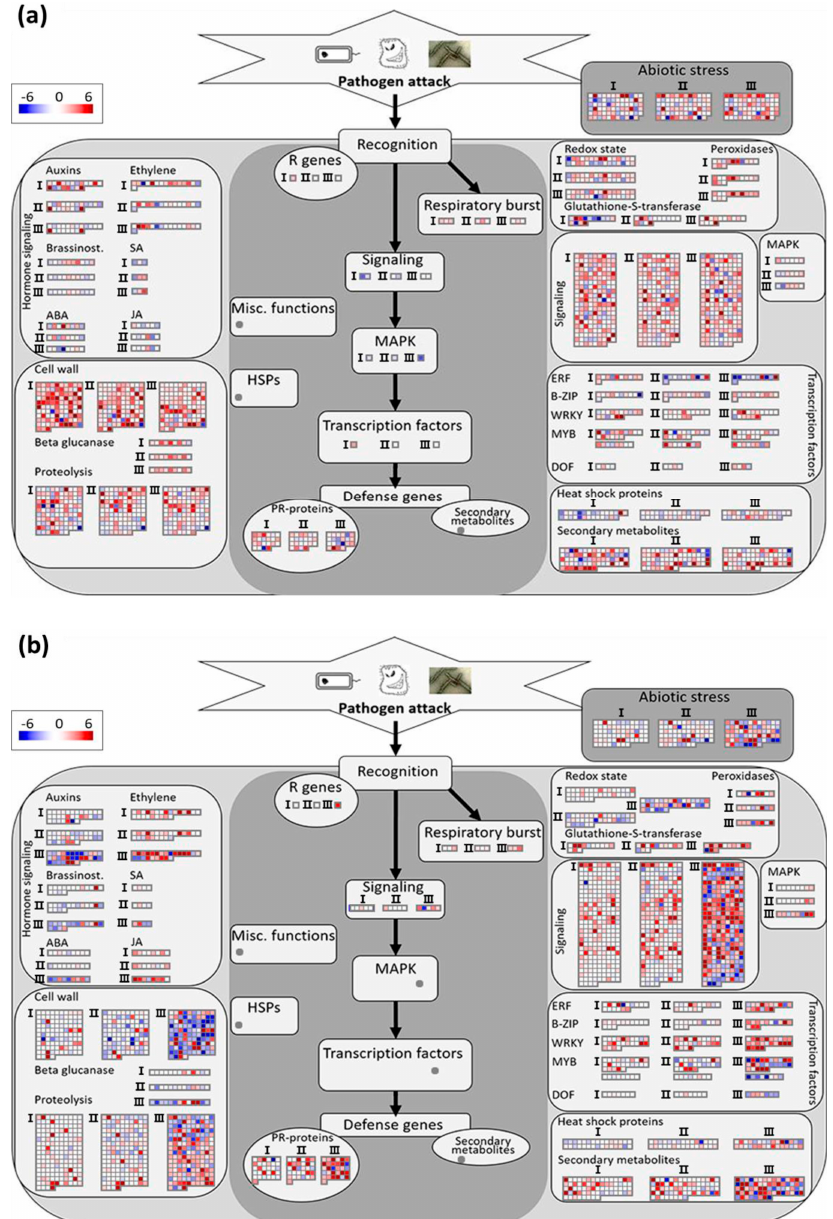
Figure 4. GO enrichment of up or down DEGs of two poplar sections in three infection stages. ( a ) Processes. ( b ) Functions. The GO enrichment was completed under a significance threshold of 0.05 following Hochberg false discovery rate (FDR) correction. The numbers in the diagram indicates the gene number belong to corresponding GO terms. Enriched GO terms were marked by orange.